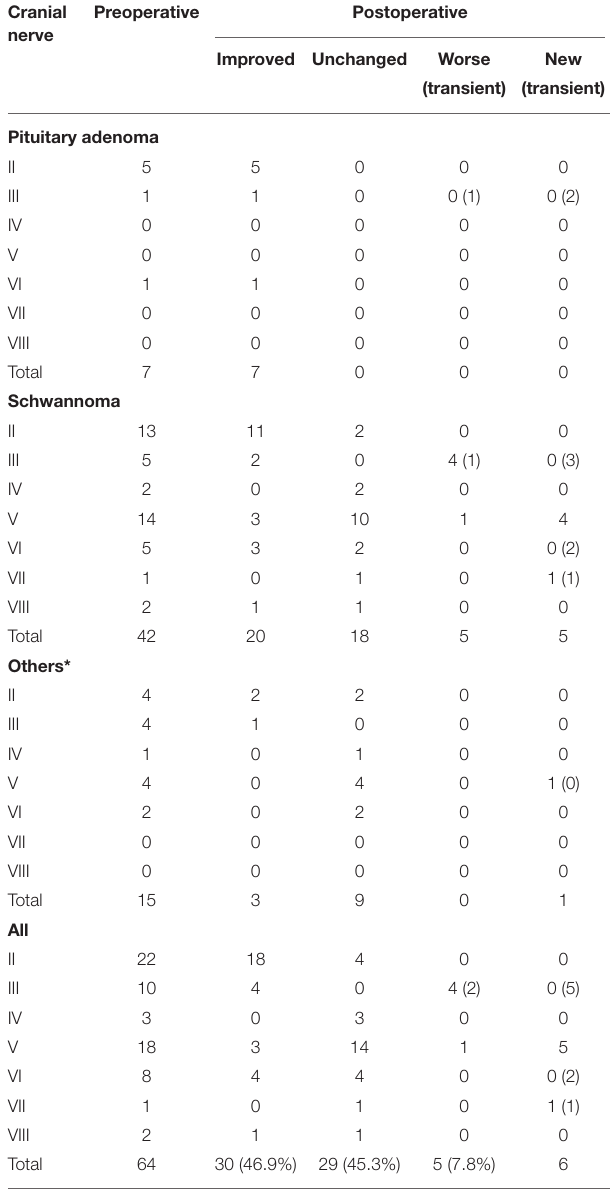
TABLE 2 | Preoperative and postoperative deficit of cranial